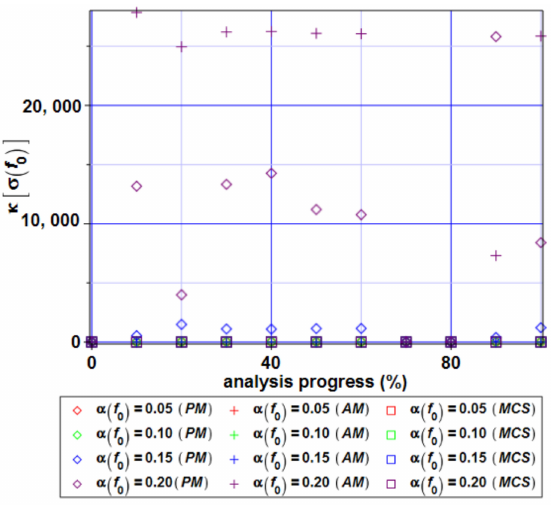
Figure 26. Kurtosis of the extreme von Mises stress κ [ σ (f 0 )] for the